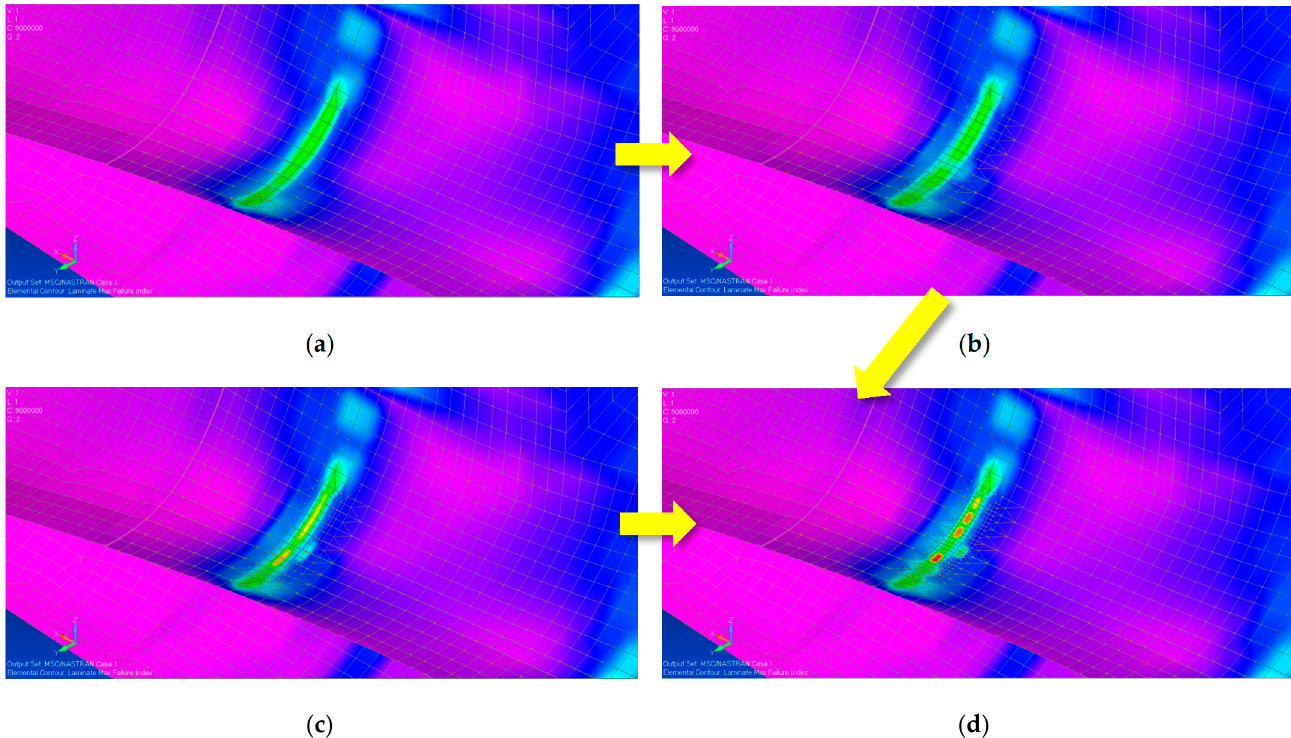
Figure 6. Normalized stress maps vs. mesh refinement level: 1st chordwise split ( a ), 1st spanwise split ( b ), 2nd chordwise split ( c ), 2nd spanwise split ( d ); normalization reference: maximum stress computed on the stress distribution reported in Figure 4 (RL).